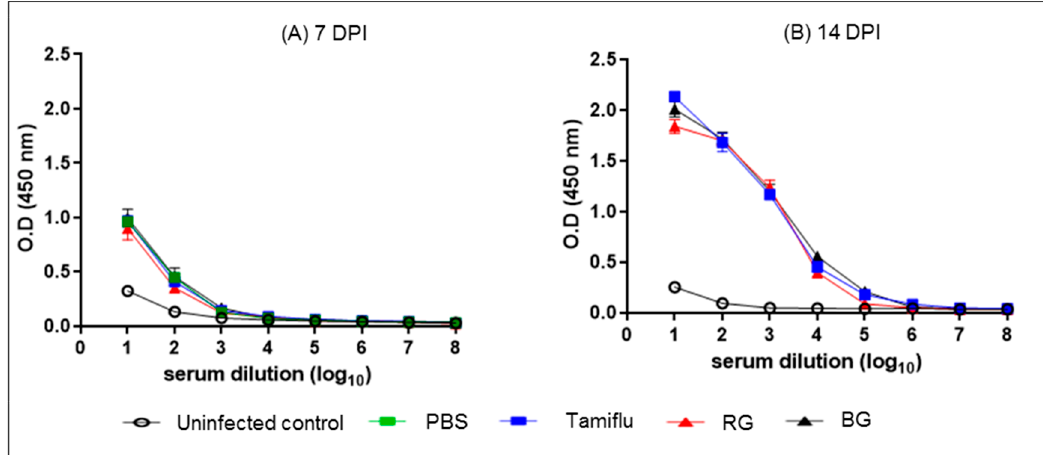
Figure 6. BG treatment does not disturb the normal development of IgG following the first virus inoculation. PBS-, Tamiflu-, RG-, and BG- treated mice were euthanized at 7 and 14 dpi to collect sera. Serum was also isolated from uninfected mice for use as an intact control. Anti-influenza A virus IgG titers were measured in sera by ELISA. Data are representative of three independent experiments. Values are the mean (n = 6 per group at each time point) ± SEM.